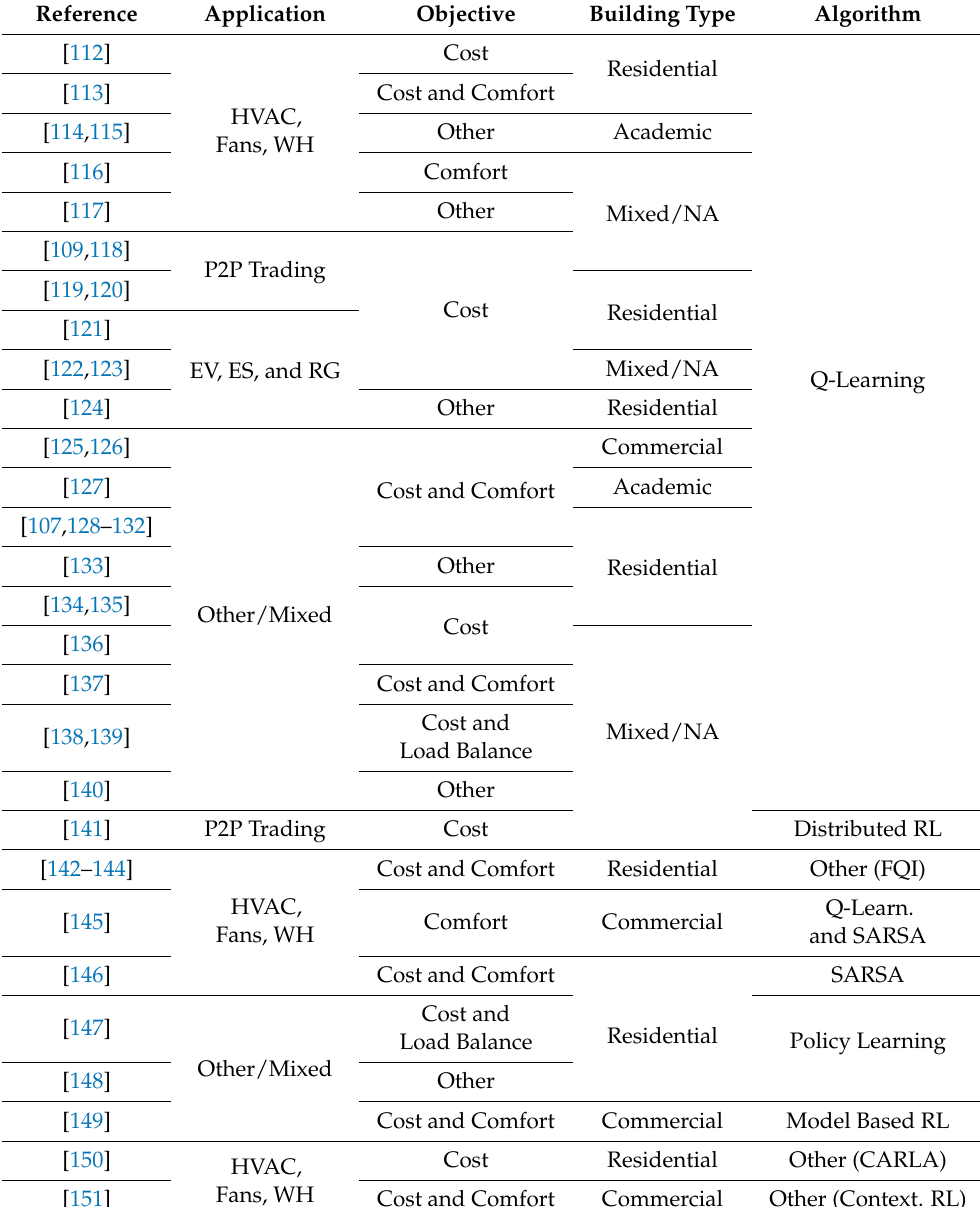
Table 1. References using Tabular Reinforcement